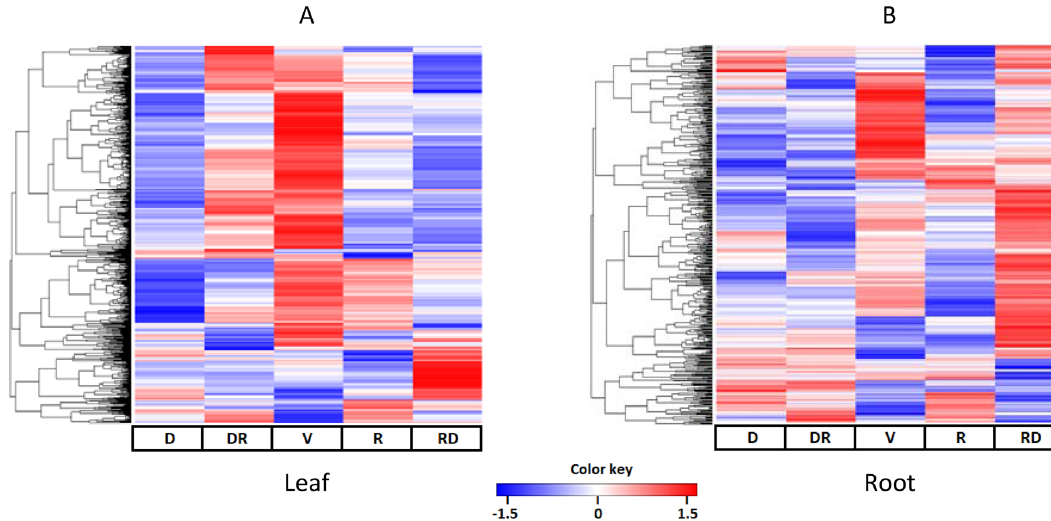
Figure 5. Heatmap visualization from a cluster hierarchical analysis of leaf and root metabolites of Gomphrena agrestis Mart. in a rock-field area in the dry and rainy seasons. D dry period, RD transition from dry to rainy period, V veranico period, R rainy period, RD transition from rainy to dry period. Performed using R-software version 3.4.1 66 .